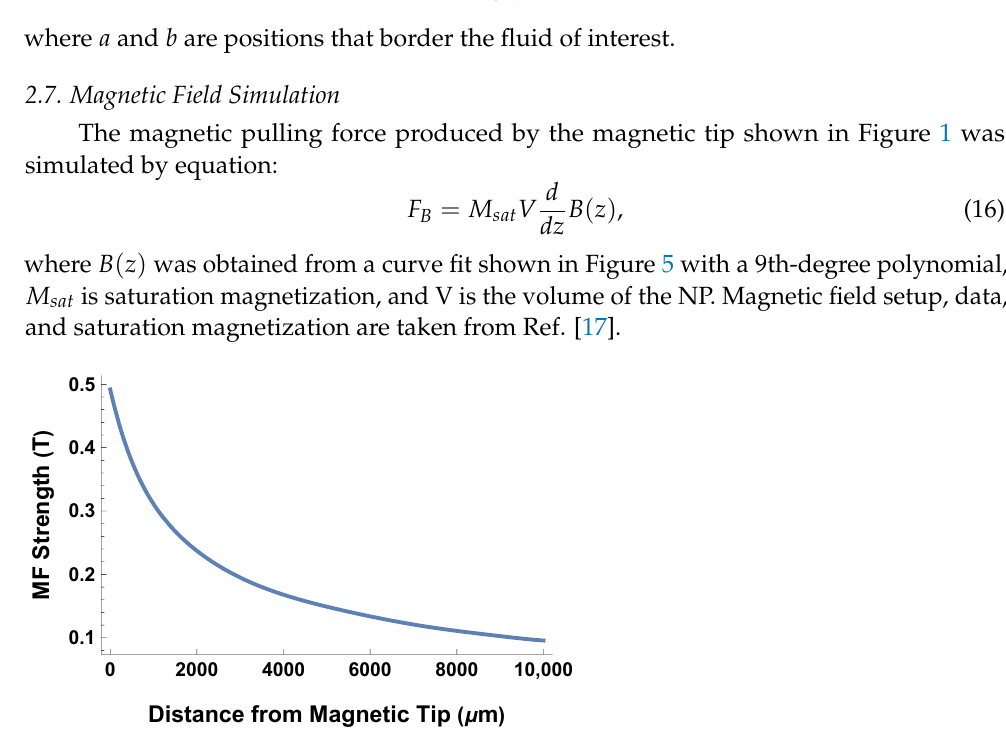
z + 1.75 ∗ 10 − 7 T z 2 − 7.47 ∗ 10 − 11 T z 3 + 2.13 ∗ 10 − 14 T z 4 m m 2 m 3 m 4